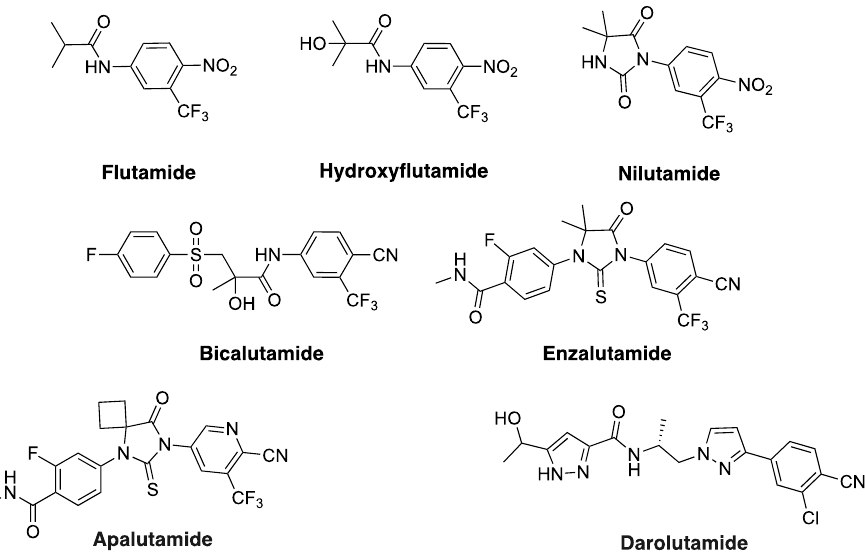
Figure 1. Chemical structures of the nonsteroidal antiandrogens (NSAA); flutamide, hydroxyflutamide, nilutamide, bicalutamide, enzalutamide, apalutamide, and darolutamide.